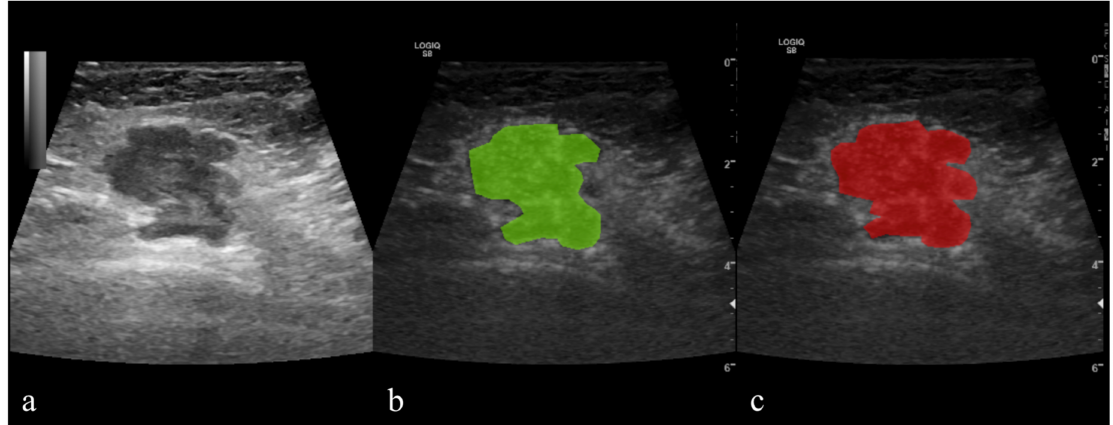
Figure 2. Contrast-enhanced ultrasound (CEUS) of histologically proven breast cancer; ( a ) grayscale image; ( b , c ) hybrid images with the tumor applied regions of interest (ROIs) that were automatically delineated by the software (green) and the final ROI after manual correction